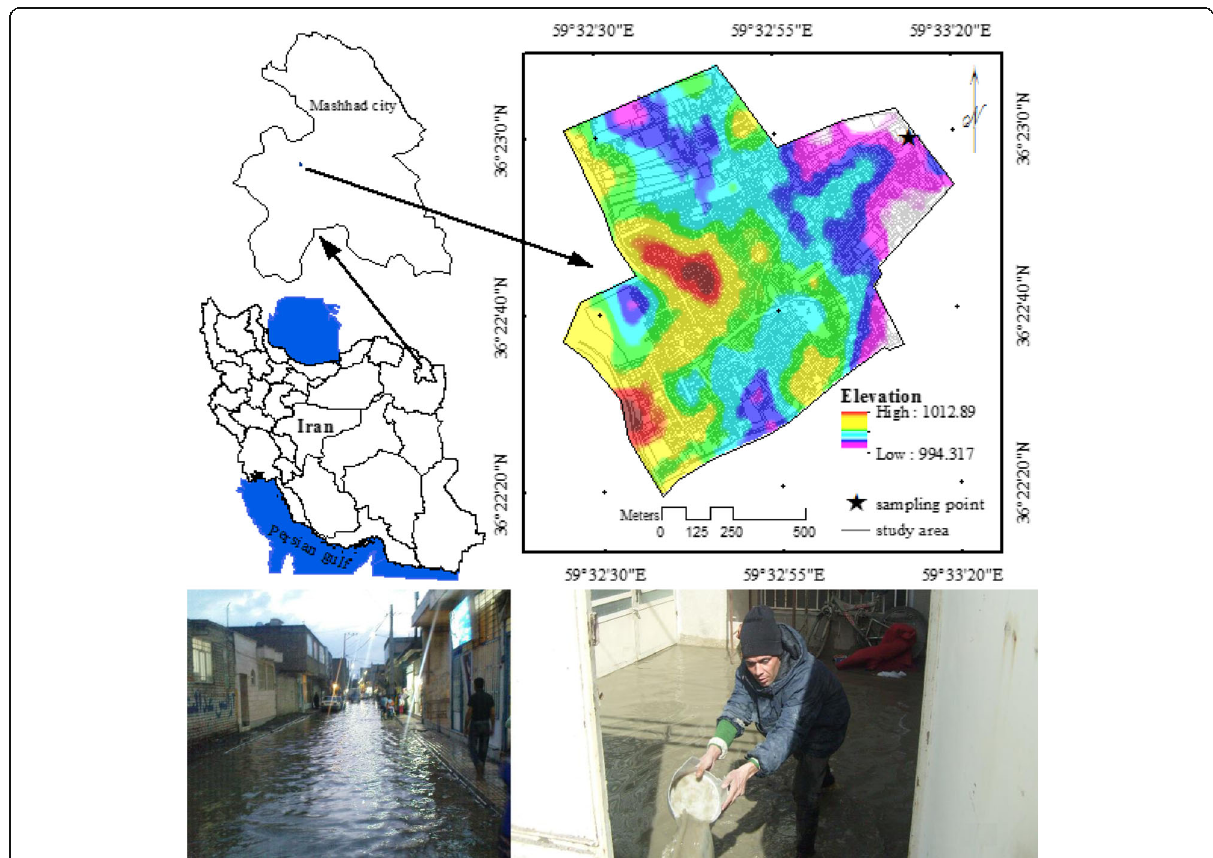
Fig. 1 Location of Emam-Ali Town in Mashhad city in Iran, and inundation in study